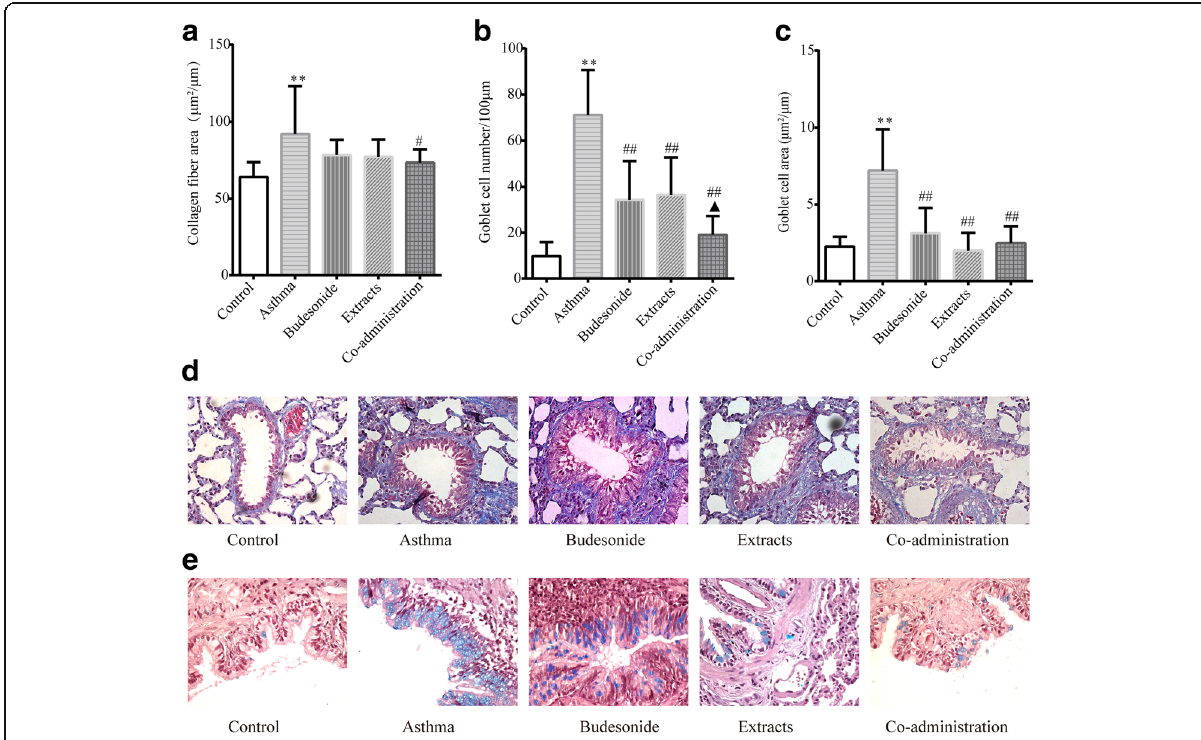
Fig. 2 Effects of budesonide and the herbal extracts on collagen deposition and goblet cell hyperplasia. ( a ) Collagen fiber area in Masson ’ s trichrome-stained sections. ( b ) The number of the goblet cells in PAS-stained lung sections. ( c ) The area of the goblet cells in PAS-stained lung sections. ( d ) Representative photomicrographs of Masson ’ s trichrome-stained sections from each group (×400). ( e ) Representative photomicrographs of PAS-stained lung sections from each group (×400). Mean ± SD, n = 10. ** P < 0.01 compared to normal control group; # P < 0.05 and ## P < 0.01 compared to asthma model group; ▲ P < 0.05 compared to budesonide